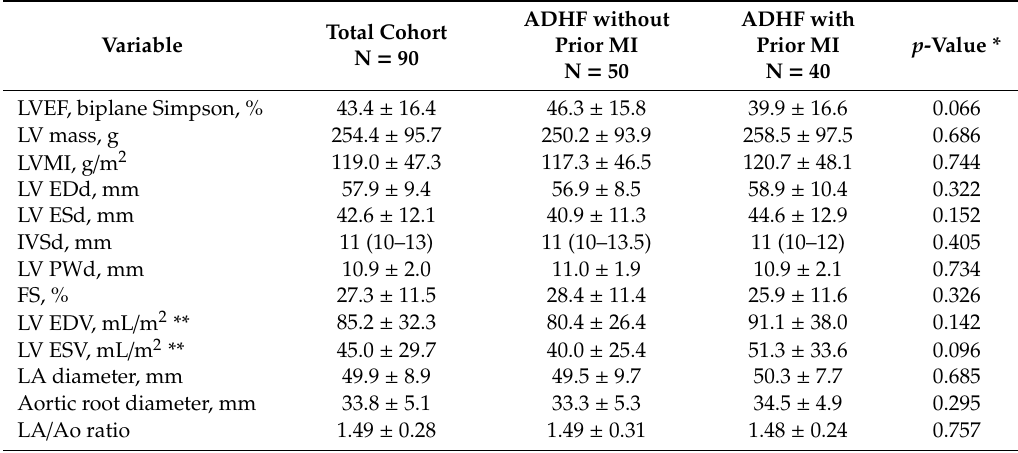
Table 3. Echocardiographic parameters of the total cohort and data stratified by the history of myocardial infarction.